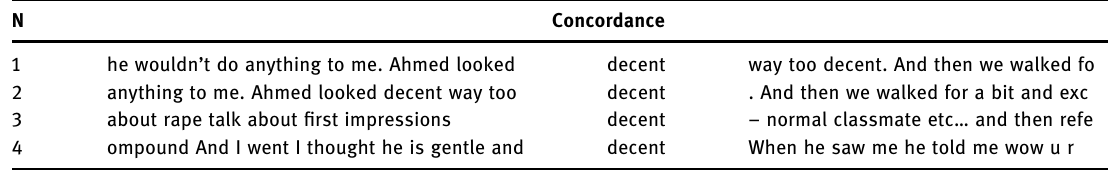
Table 10: Concordance lines for decent N